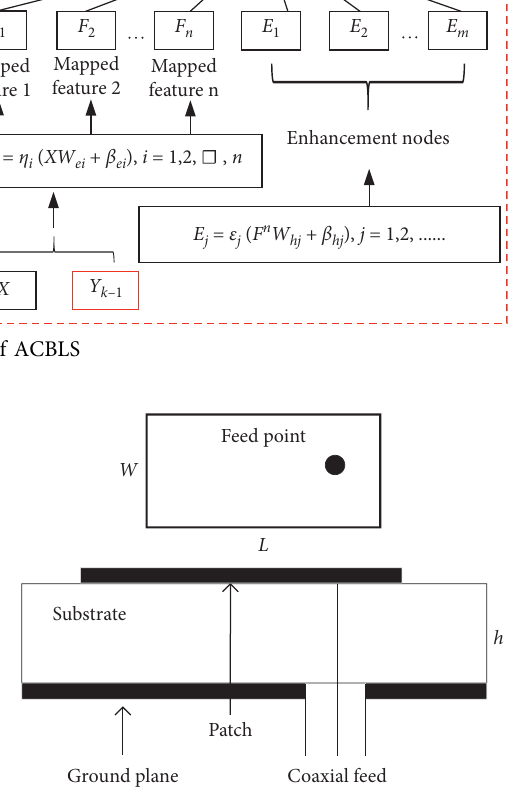
Figure 3: Schematic diagram of